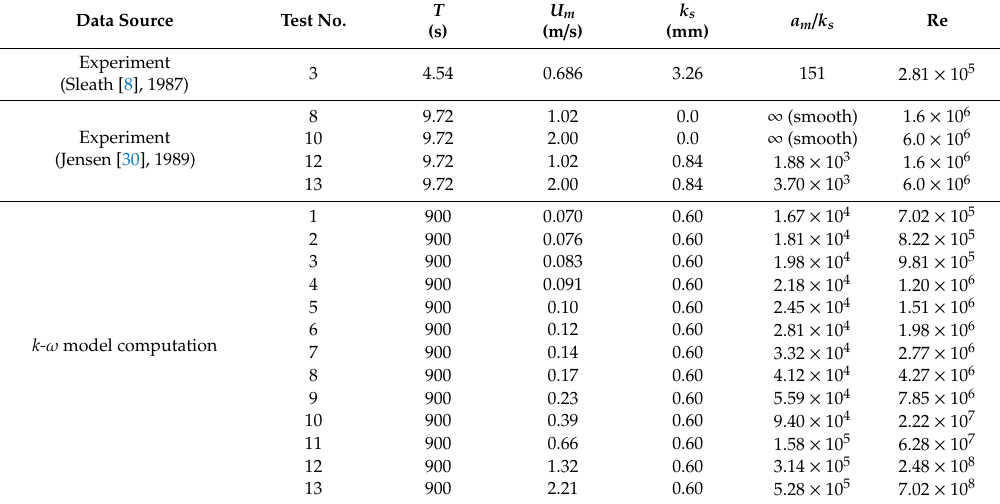
Table 1. Conditions of laboratory experiments by Sleath [8] and Jensen [30] and k- ω model computation. Data Source Test